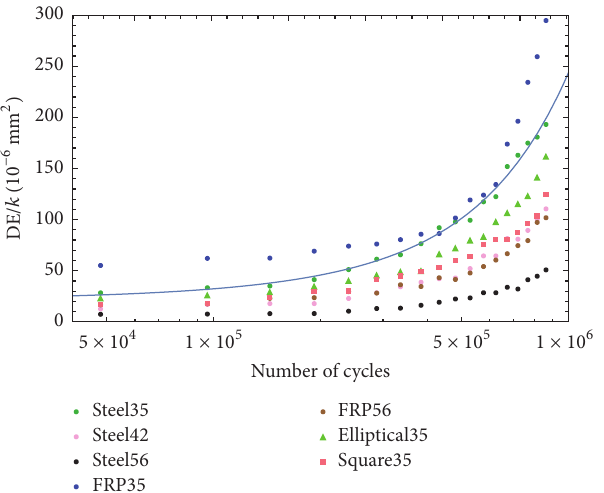
Figure 12: Strains of dowels at loaded sides.